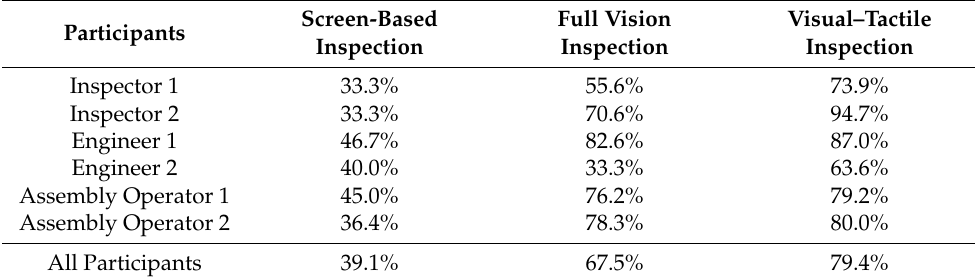
Table 5. Defect classification accuracy of each participant by inspection method.